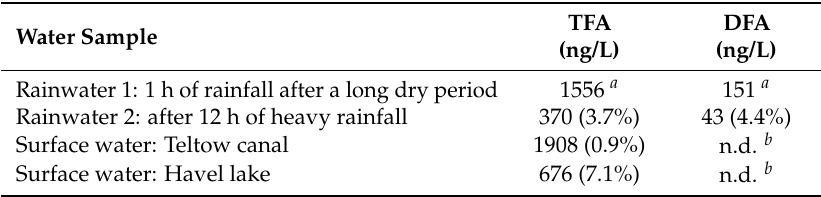
Table 1. Trifluoroacetic acid (TFA) and difluoroacetic acid (DFA) concentrations in rainfall and surface water (means and relative standard deviations, n = 2).